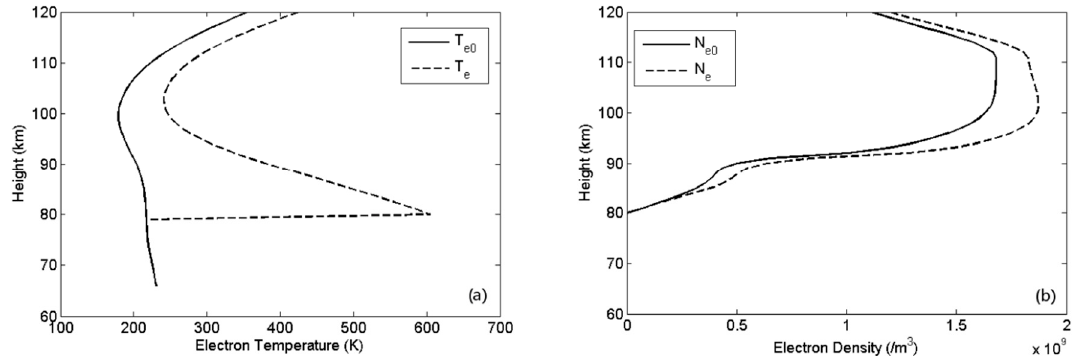
Figure 6. Profile of ( a ) electron temperature and ( b ) electron density before (solid line) and after (dashed line) preheating on 16 March 2008, 1300 UT, HAARP.